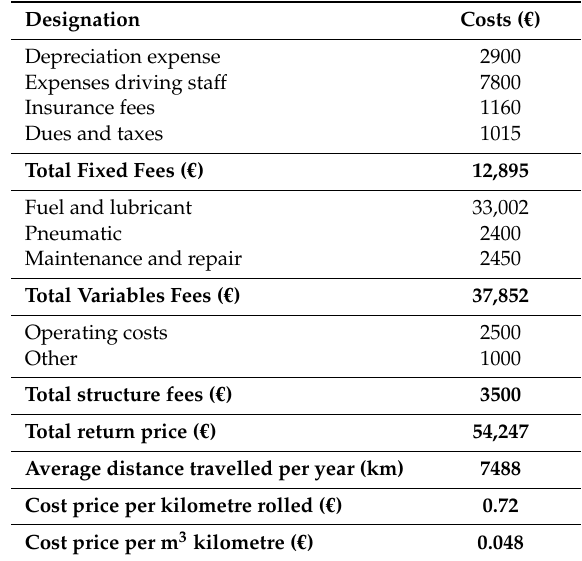
Table 9. Annual costs related to the various services provided for the execution of an embankment.